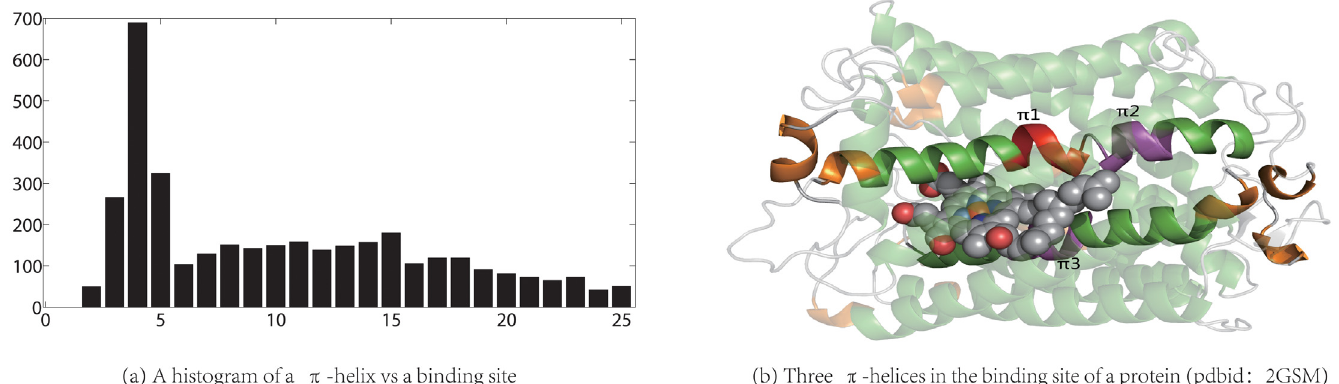
Fig 7. A histogram of a π -helix vs a protein-ligand binding site. Figure (a) shows a histogram of the π -helix assigned by our algorithm vs a protein-ligand site. The x-axis is the distance (in Å ) between the ligand and a π -helix while the y-axis is the number of π -helices. Figure (b) shows an example illustrating the difference in π -helix assignment by our algorithm and DSSP . Our algorithm assigns three π -helices labeled as π 1 , π 2 and π 3 , all of them are in the ligand binding site but DSSP fails to assign π 1 though it is able to identify both π 2 and π 3 . In this figure, α -helices are in green, 3 10 -helices are in orange and the ligand is shown as